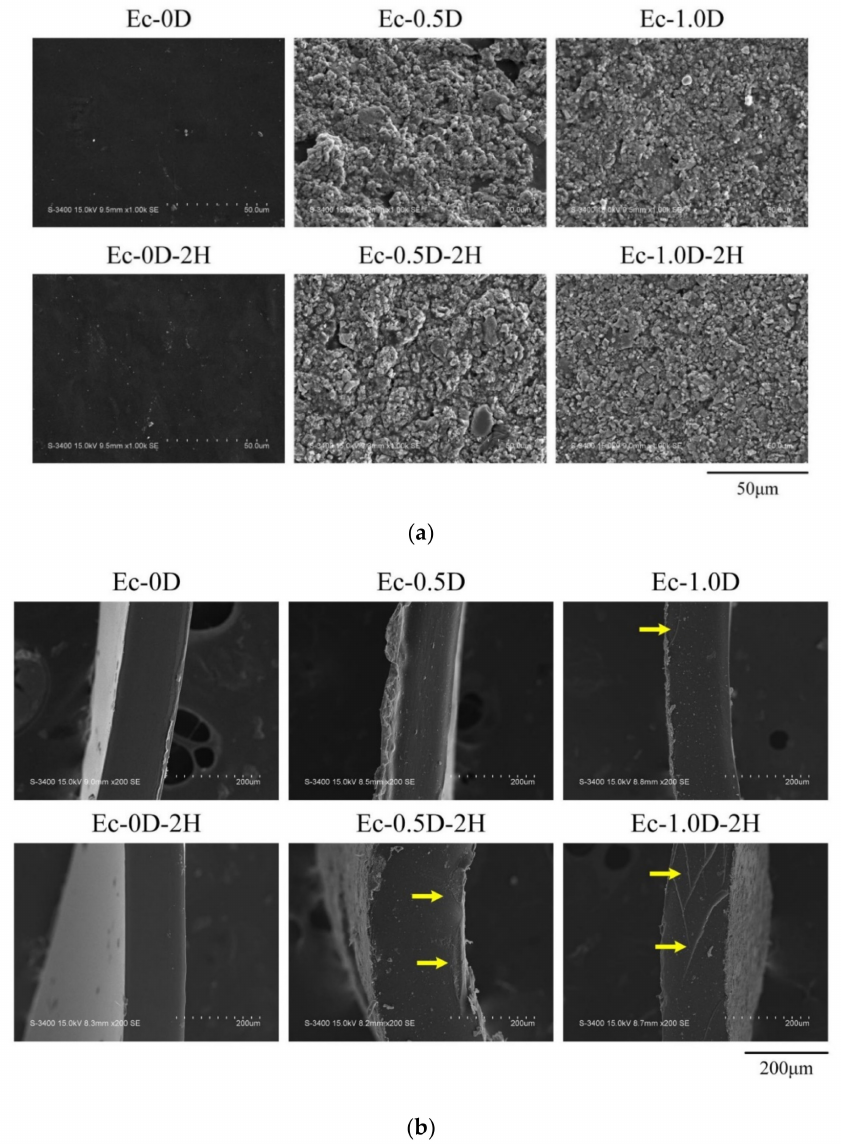
Figure 4. Surface images of different hydrogel membranes of EDC crosslinked without modified DCPA (Ec-0D) and with modified DCPA (Ec-0.5D and Ec-1.0D), and hinokitiol-impregnated hydro- gels Ec-0D-2H, Ec-0.5D-2H, and Ec-1.0D-2H ( a ) and fracture surfaces of the hydrogel membranes after tensile testing ( b ) (the yellow arrowhead represents the toughness slips of the ductile failure of hydrogels through the